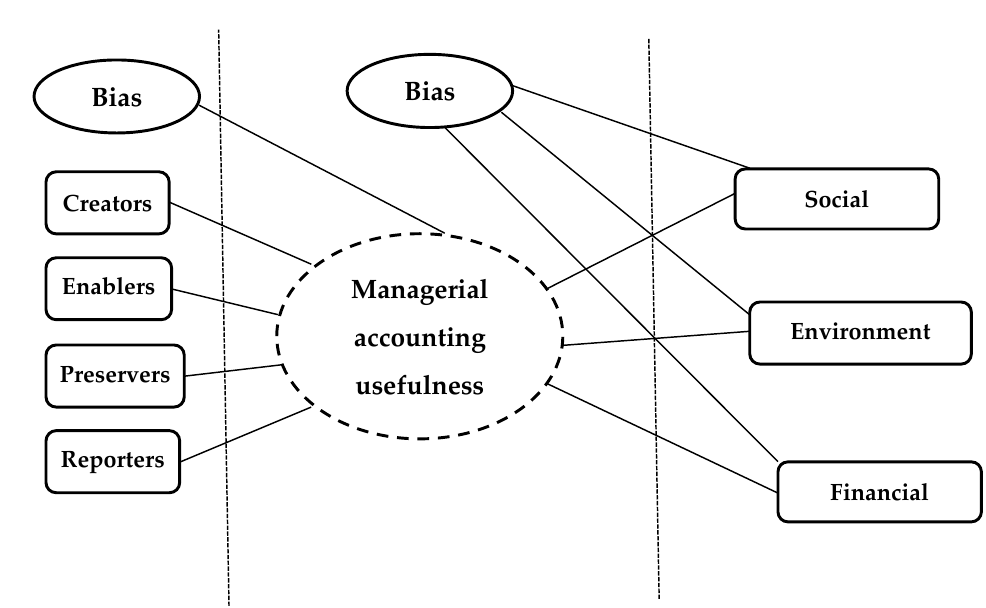
Figure 2. Conceptual model. Source: the authors’ design based on [2,15,28,29,32].